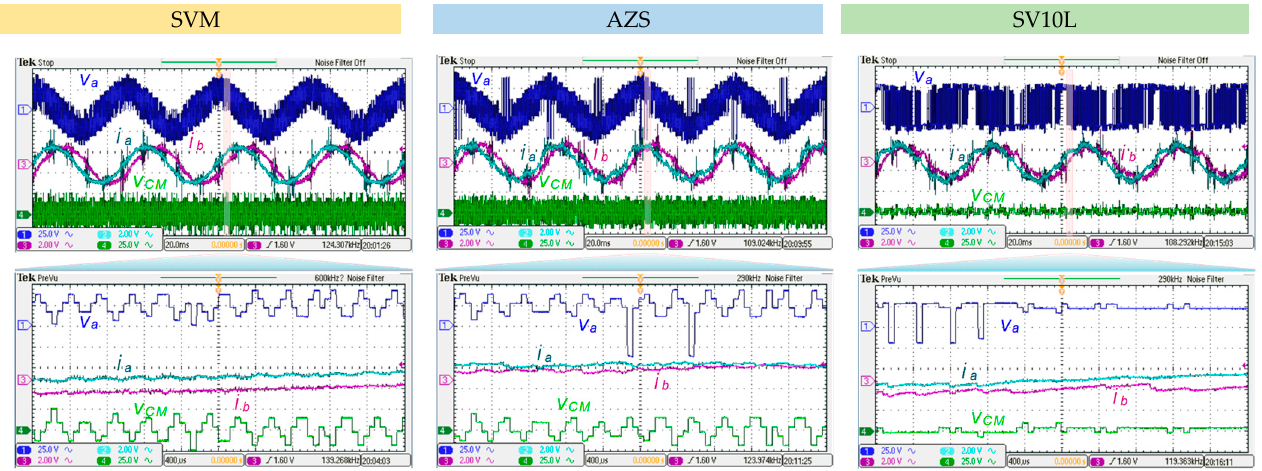
Figure 10. Experimental results of phase voltage, two of the line currents, and the CMV waveforms for the analyzed PWM schemes.